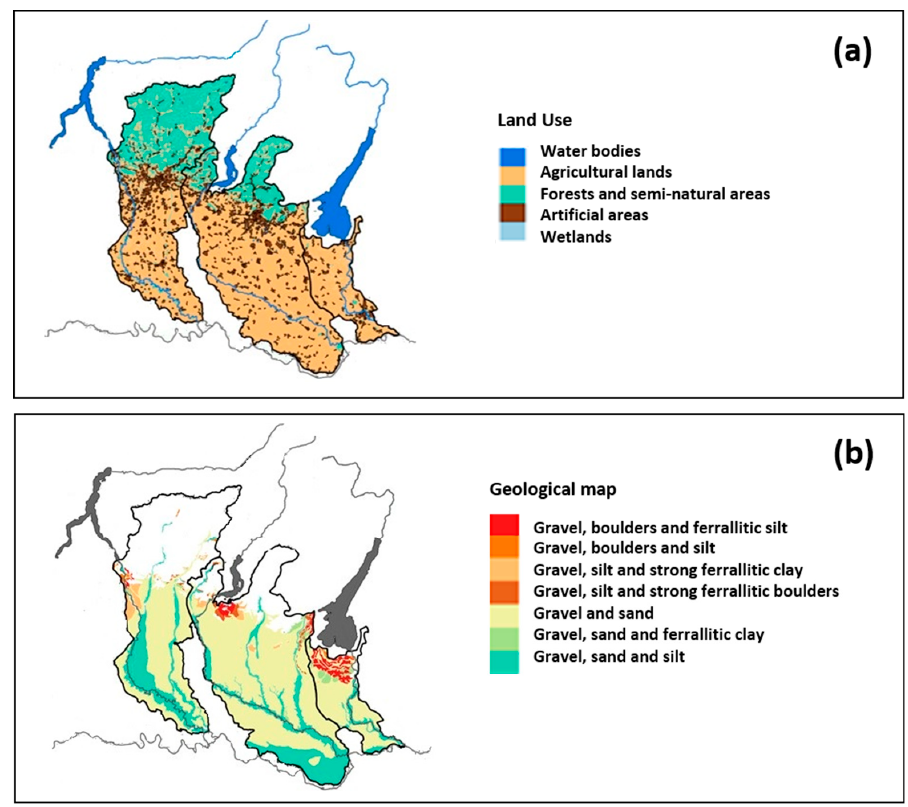
Figure 2. Land use according to the Corine Land Cover 2006 ( a ) and geological map ( b ) of the Adda, Oglio, and Mincio basins. Data source: [60,61]. Table 1. Physical features of the Adda, Oglio, and Mincio watersheds and delimitation of the portion of the watersheds which are the object of this study.